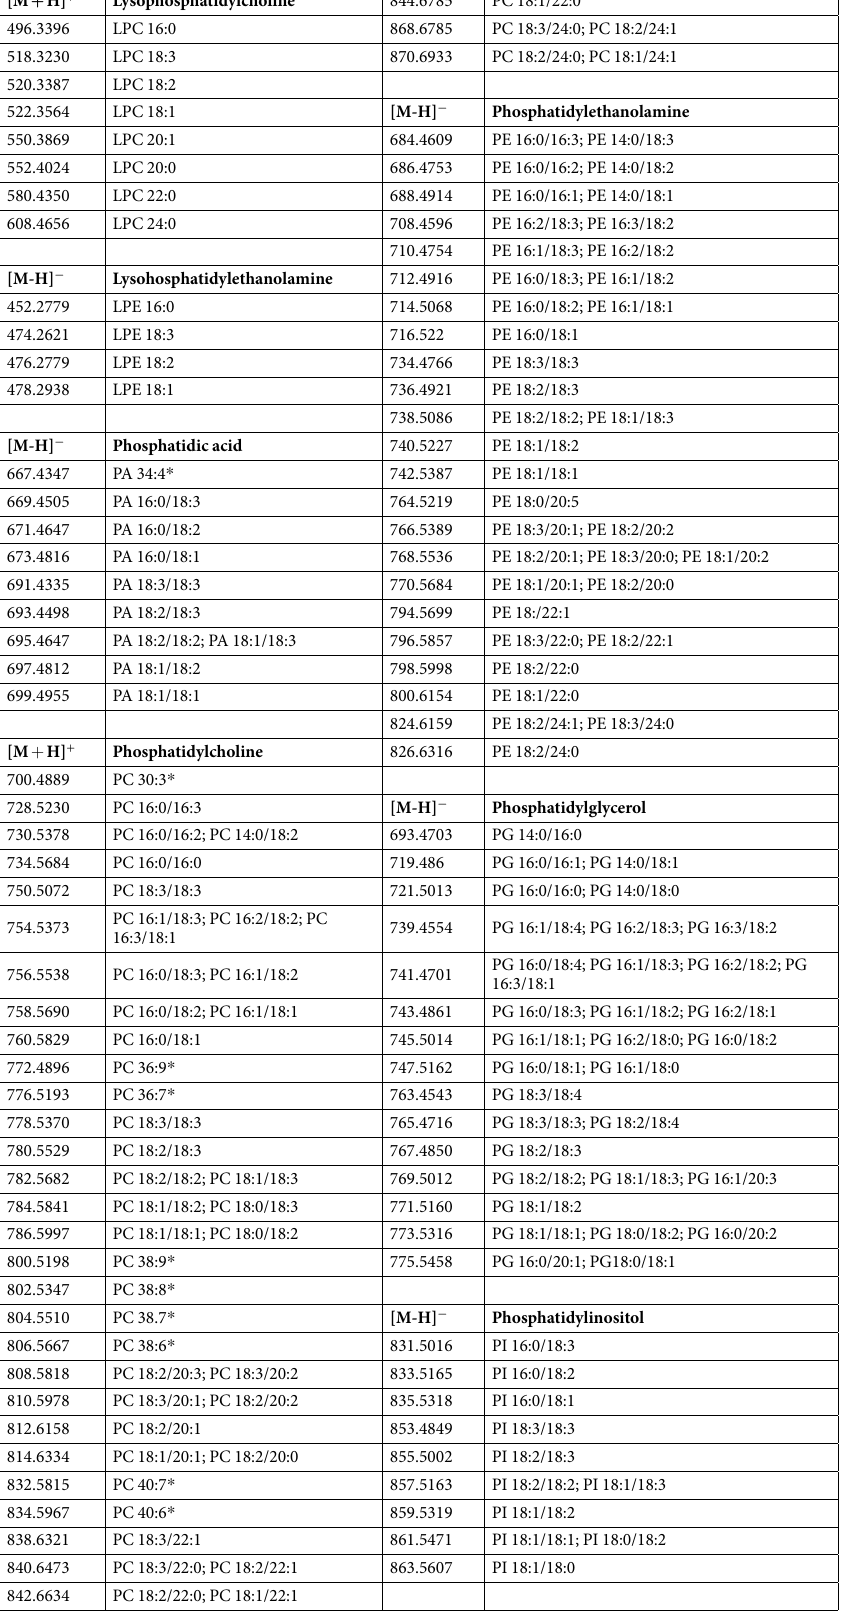
Table 1. Phospholipids molecular species identified by LC-MS and tandem MS (MS/MS) from total lipid extracts of Halimione portulacoides leaves. * confirmed m/z and class but missing fatty-acyl information to identify